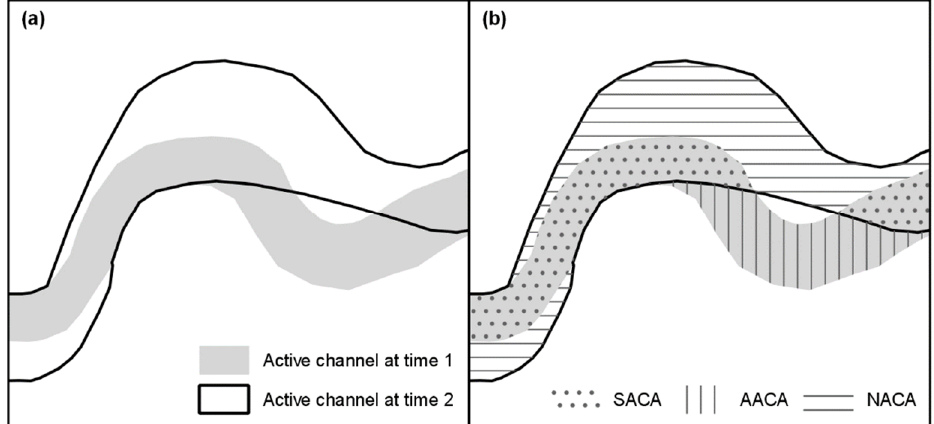
Figure 4. ( a ) Overlapping of a couple of active channels referring to two different times and ( b ) definition of stable (SACA), abandoned (AACA) and newly formed (NACA) active channel area.